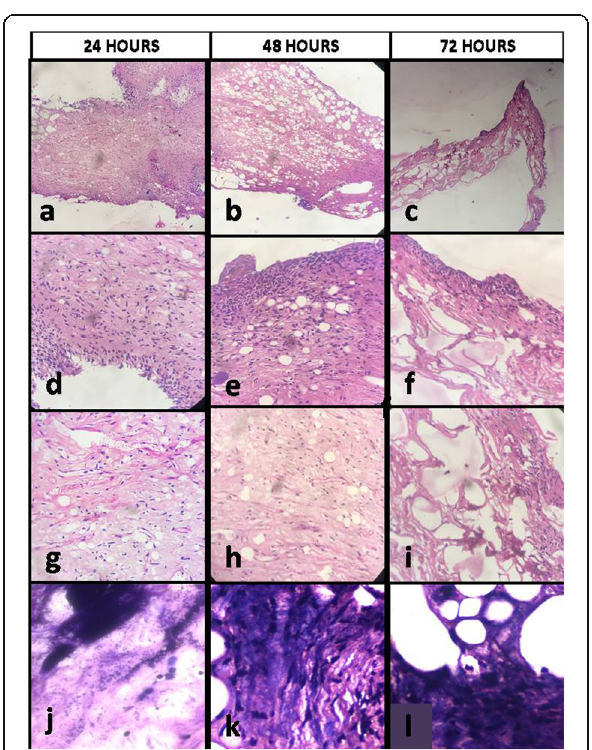
Fig. 3 Histological and microbiological assessment after 24, 48, and 72 h of extraction. a – c Pictomicrograph shows increasing vacuolations of the ECM with time (× 100). d – f Intact odontoblastic layer seen at the periphery (× 400). g – i Gradual degeneration of endothelial cells and RBCs (× 400). j – l Tissue Gram stain (Brown and Brenn) highlighting the presence of Gram-positive cocci consistent with Staphylococci and Streptococci species (×